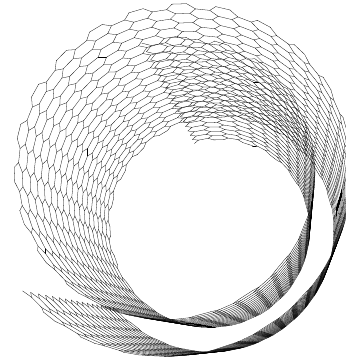
Figure 3. Perspective view of a rolled sheet of graphene of 16 nm length. The curvature radii at the starting and ending edges of the scroll are 1.24 and 1.80 nm,